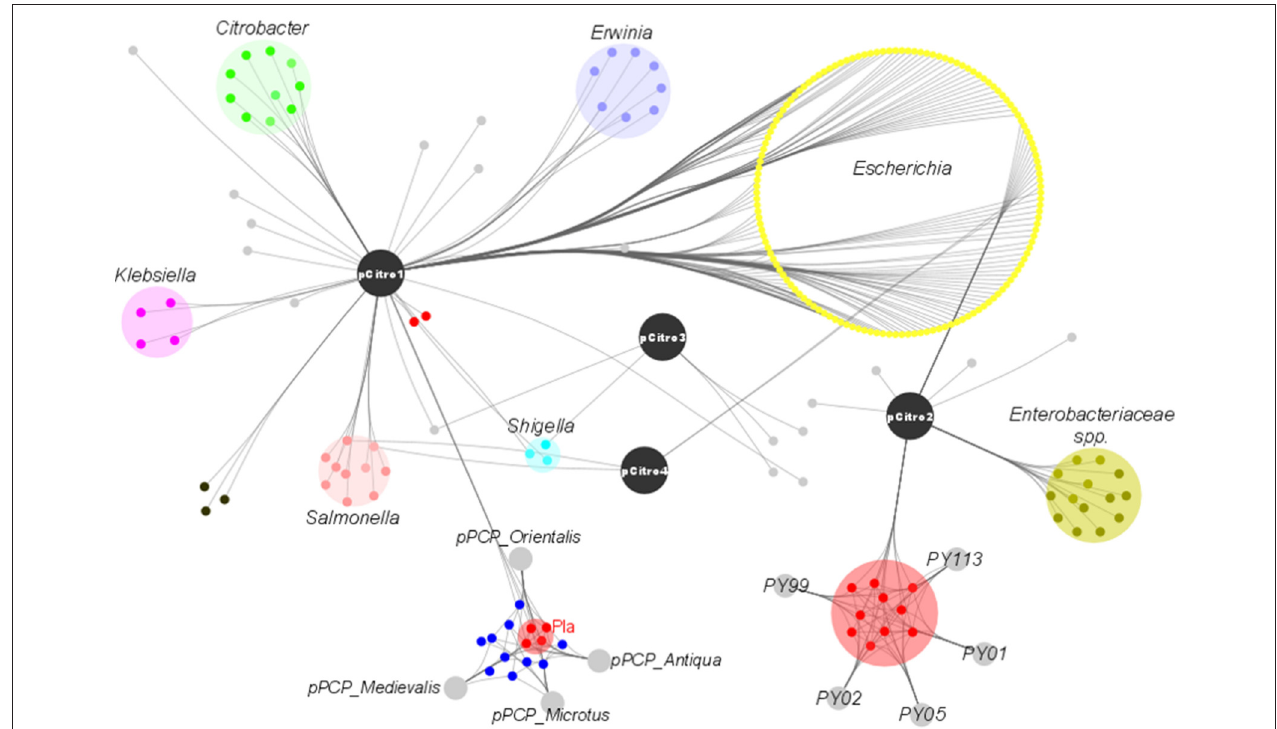
FIGURE 5 | The taxonomic diversity of the plasmidome. Protein origins of the plasmidome using phylogenetic inference or best Blast hit. The pCitro1 proteins were related to multiple genera of the Enterobacteriaceae group including Klebsiella , Salmonella , Erwinia , Escherichia , Citrobacter and Yersinia . Four proteins of the pCitro1, including Pla, are exclusively shared with the virulence-associated 9.6kb Y. pestis pPCP1 plasmid biovar Antiqua, Orientalis, Microtus, and Medievalis. The pCitro2 proteins were related to the Enterobacteriaceae group including the Yersinia genus. Several proteins of pCitro2 are identified as homologs to those from